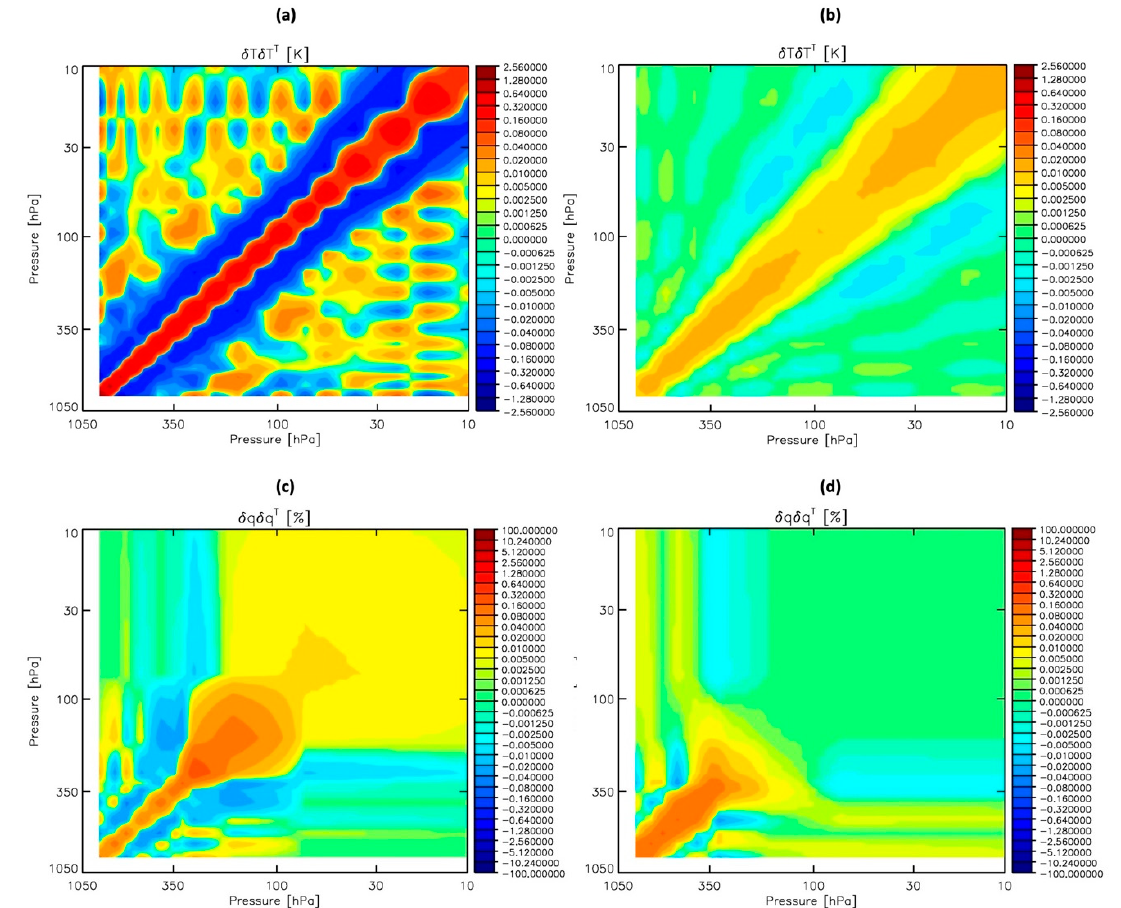
Figure 7. For a single CLIMCAPS datum, the retrieval error covariance matrix for temperature can be parameterized as a contribution from ( a ) the null space that propagates a priori estimate uncertainty, and ( b ) the spectral space that propagates all sources of error and uncertainty with a spectral component, such as instrument error, uncertainty due spectral interference from background state variables as well as forward model uncertainty. The same is true for H 2 O retrievals with error covariance matrices for the ( c ) null space, and ( d ) spectral space. The color scale is highly non-linear to highlight the subtle off-diagonal structures.